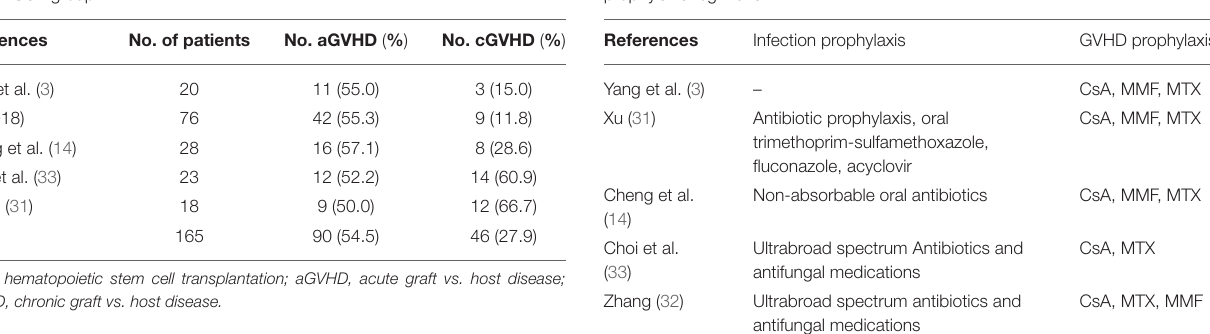
TABLE 3 | Summary of the incidence of aGVHD and cGVHD in the haplo-HSCT group.